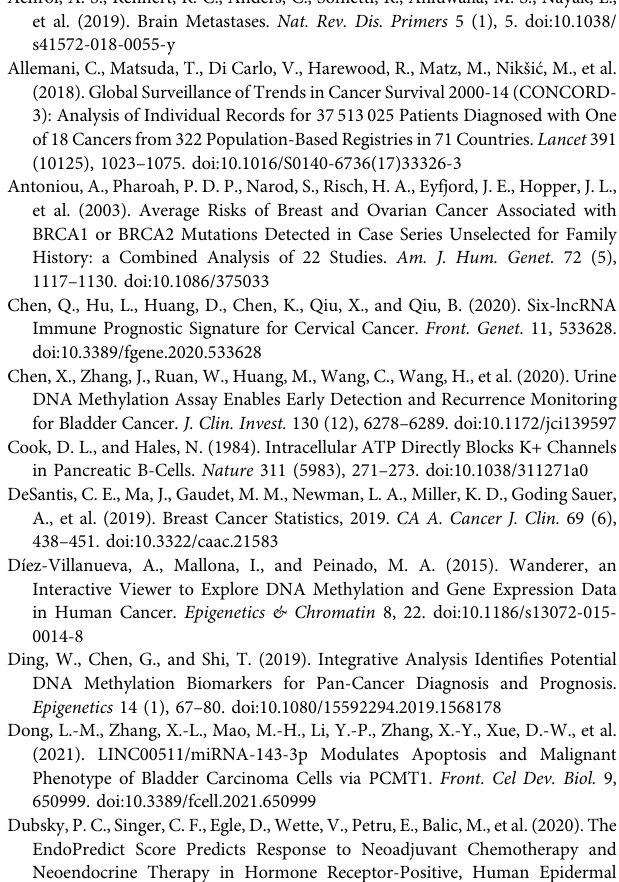
Growth Factor Receptor 2-negative Breast Cancer Patients from the ABCSG-34 Trial. Eur. J. Cancer 134, 99 – 106.